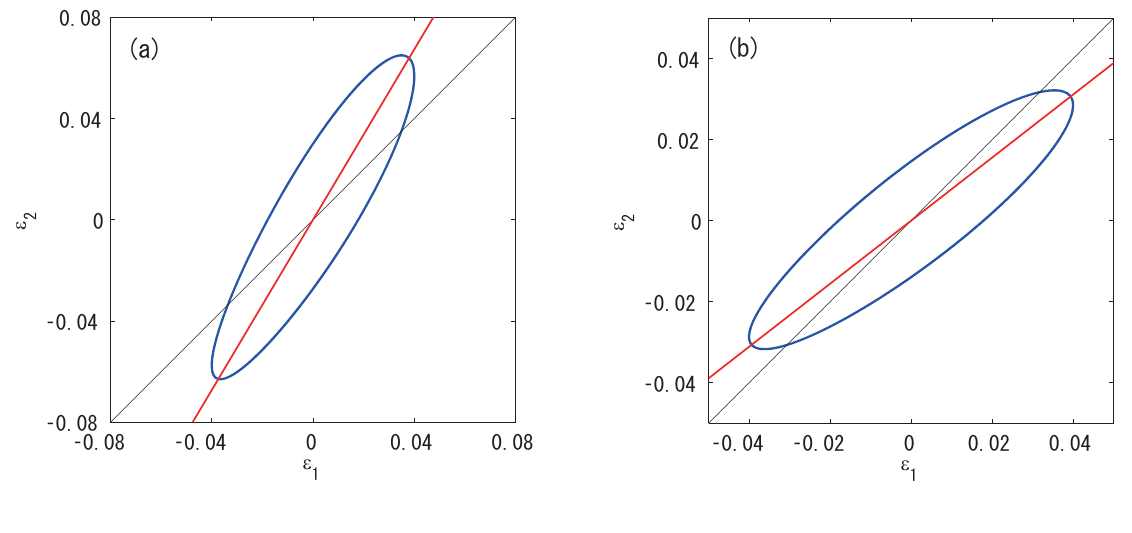
Figure 6. Two examples of an asymmetric ellipse describing the relationship between (cid:15) and (cid:15) . In ( a ), the slope of the major axis exceeds unity, meaning that the average value of 2 | (cid:15) | is less than that of | (cid:15) | . This suggests that algorithm-1 is more robust than algorithm-2 in 1 2 terms of the propagated error; ( b ) The opposite case as is shown in ( a ), the conditions under which algorithm-1 is less robust than algorithm-2.